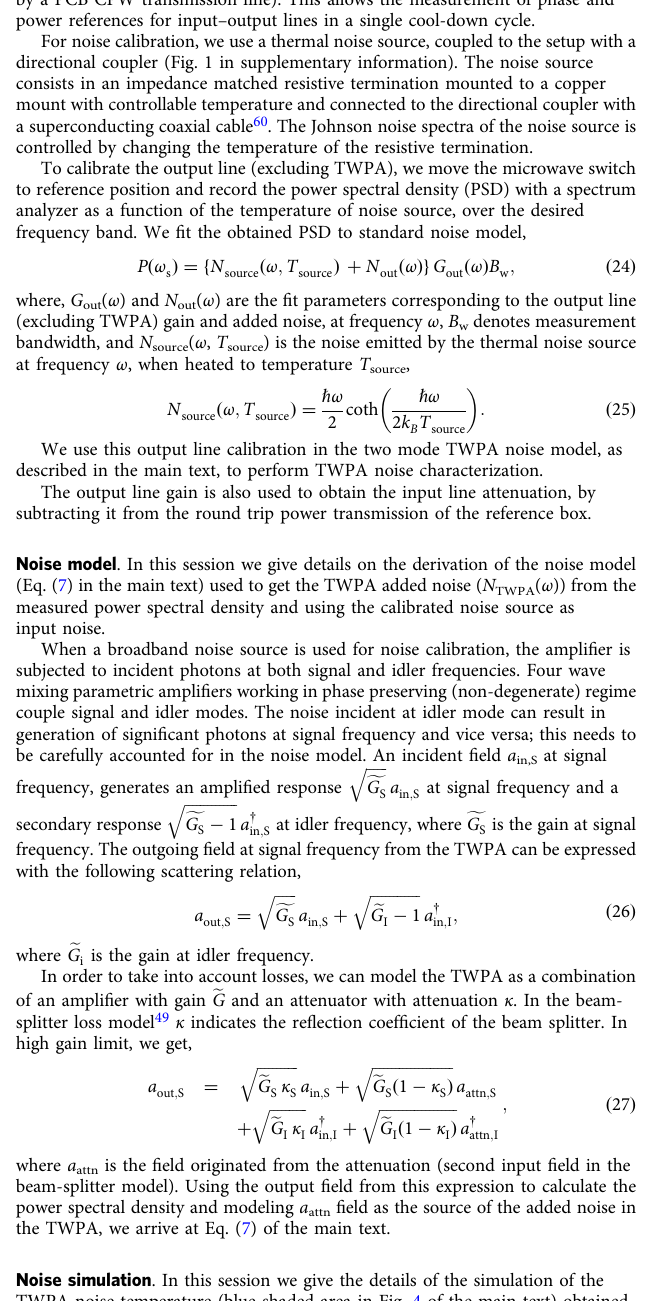
Fig. 5 Transmission loss. Transmission loss of the device for two selected fl ux values, Φ